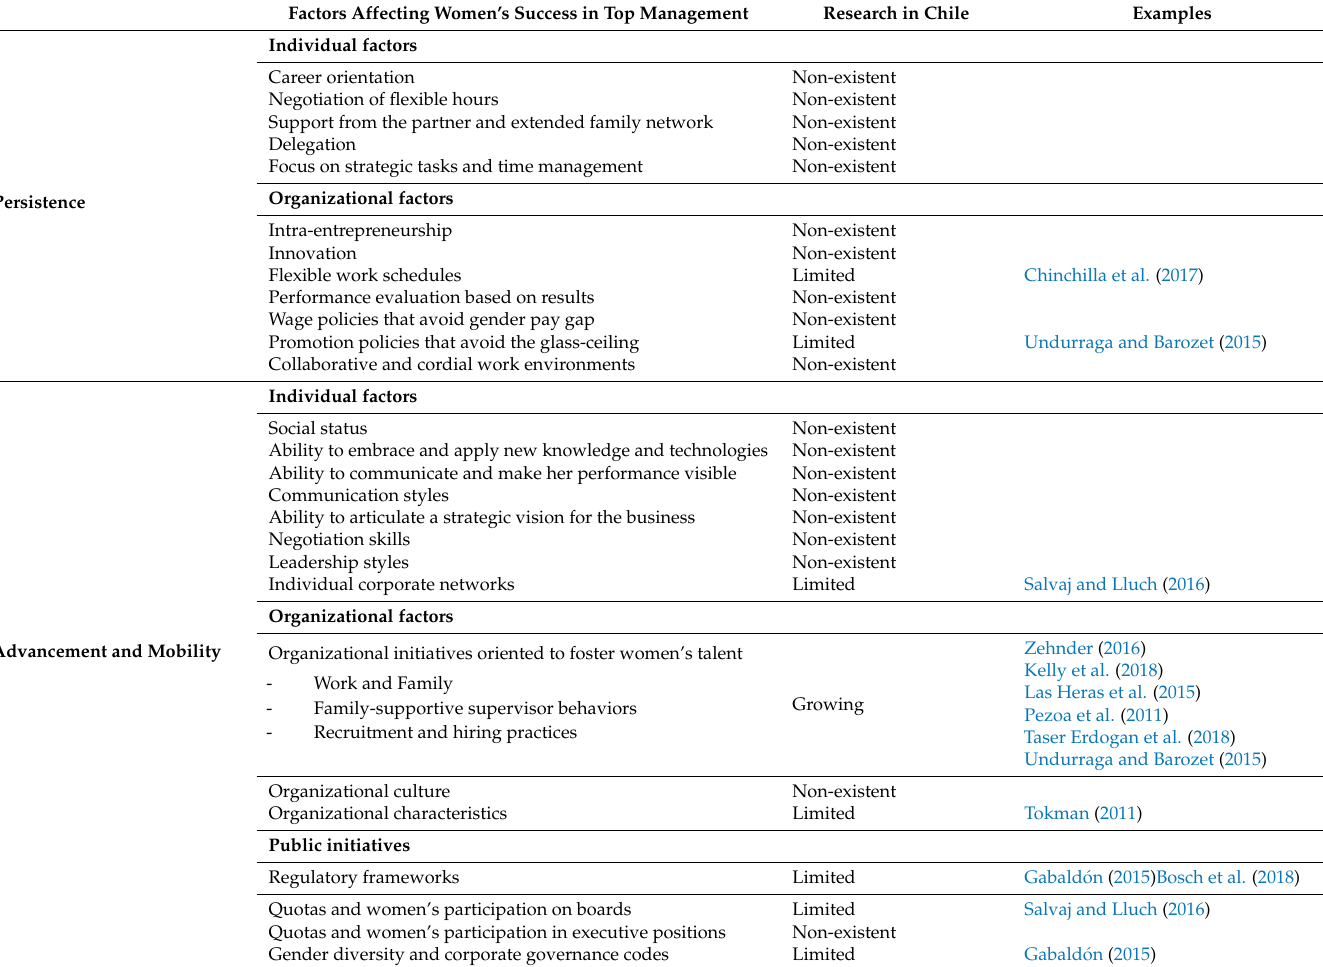
Table 1. Summary of research on the factors that affect women’s success in senior